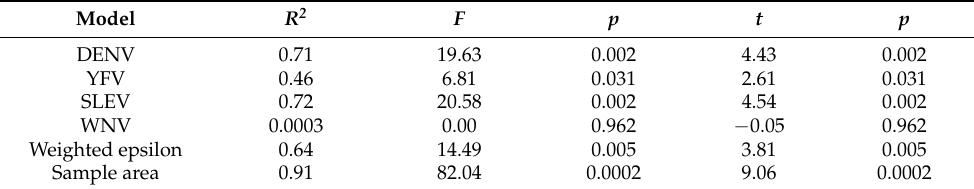
Table 2. Regression coefficient and corresponding t - and p -values for each model.